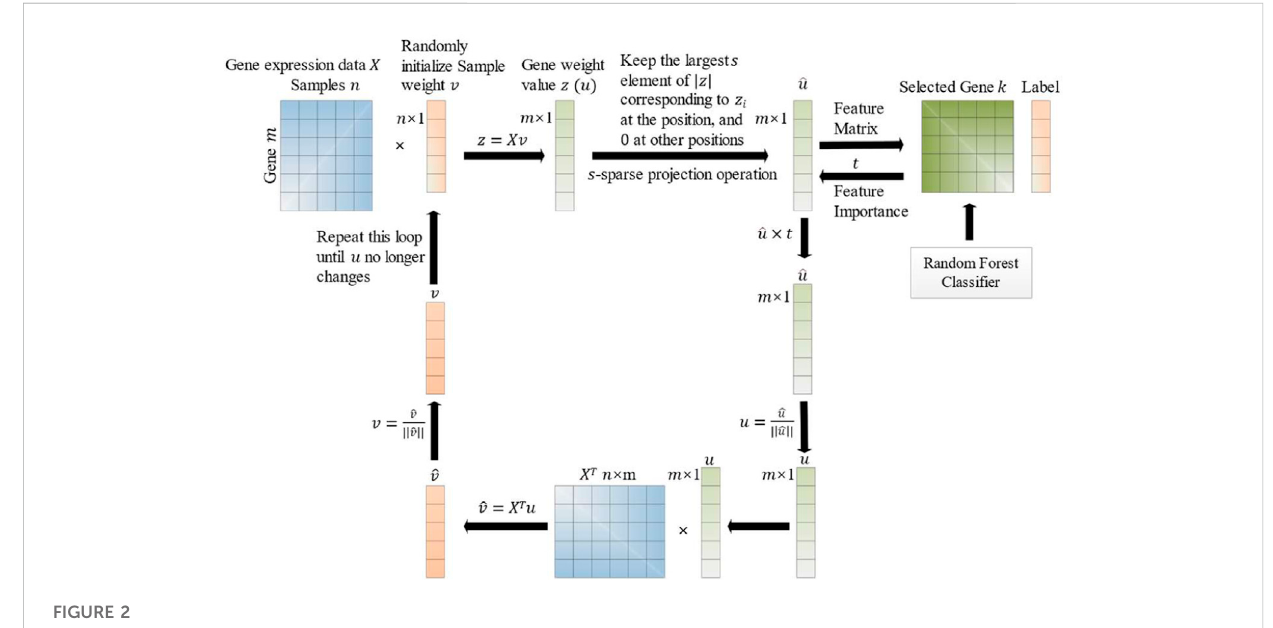
FIGURE 2 Work fl ow of SPCA with feature (for example, gene)